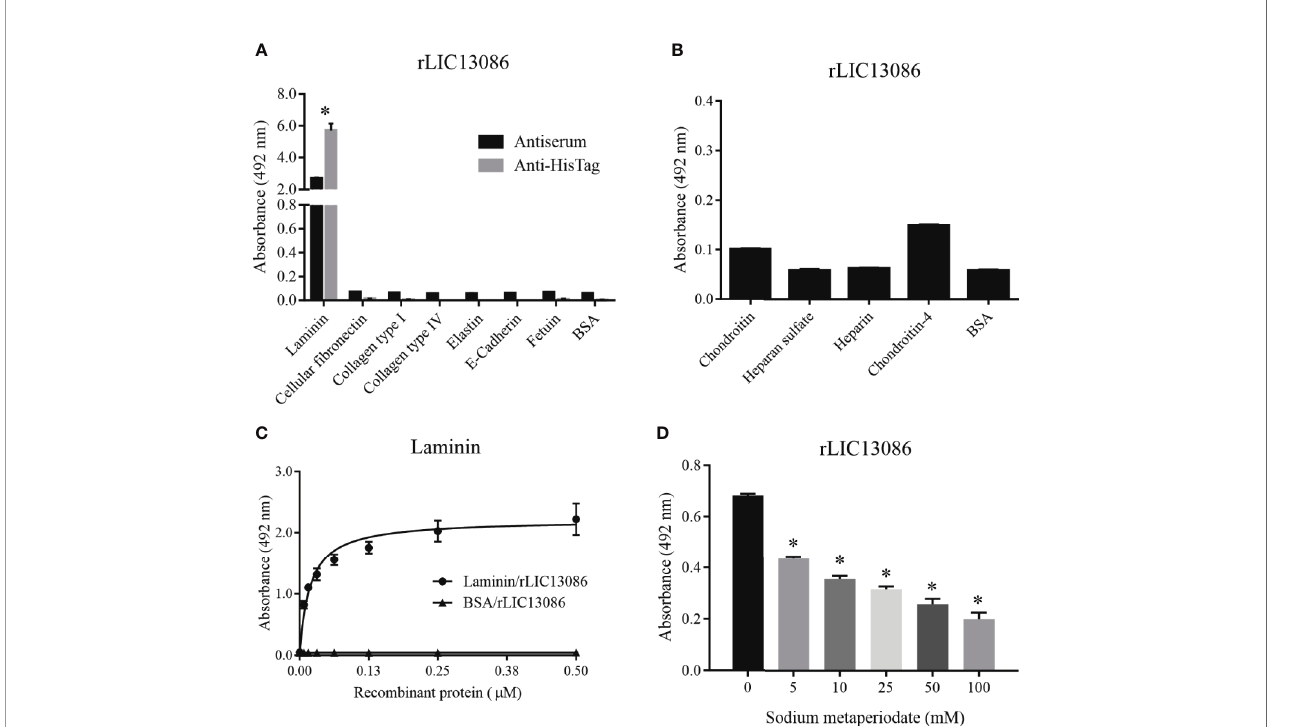
FIGURE 4 | Binding of rLIC13086 with extracellular matrix components. (A) Each ECM component was coated onto ELISA plates for 16 h at 4°C and incubated with rLIC13086 (1 m g) for 2 h at 37°C. The detection was performed by incubation with HRP-conjugated anti-HisTag mAb (1:10,000), or anti-rLIC13086 antiserum (1:5,000) and secondary HRP-conjugated anti-mouse IgG (1:5,000). (B) Glycosaminoglycans were immobilized onto ELISA plates for 16 h at 4°C, incubated with rLIC13086 (1 m g) for 2 h at 37°C, following detection by HRP-conjugated anti-HisTag mAb (1:10,000). (C) Coated laminin (1 m g) was incubated with different concentrations of rLIC13086 (0 – 0.5 m M) for 2 h at 37°C and detected with HRP-conjugated anti-HisTag mAb (1:10,000). (D) Laminin (1 m g) was immobilized onto ELISA plates, incubated with different concentrations of sodium metaperiodate (0 – 100 mM) and interacted with rLIC13086 (1 m g) at 37°C for 2 h. Detection was performed with HRP-conjugated anti-HisTag mAb (1:10,000). BSA and Fetuin were used as negative controls. The bars represent the means of three different experiments in triplicates with the corresponding standard deviation. * Indicates signi fi cant difference calculated by Student t- test with p-values <